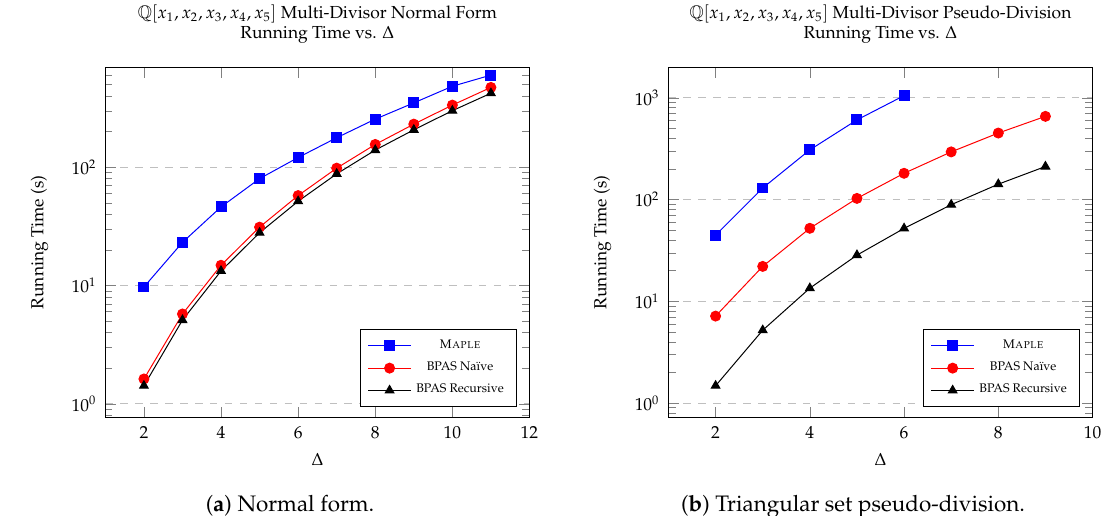
Figure 8. Comparing normal form and triangular set pseudo-division over Q . For each, the naïve algorithm, the recursive algorithm, and the algorithm within M APLE are compared. Polynomials are in 5 variables and the coefficient bound is 128.